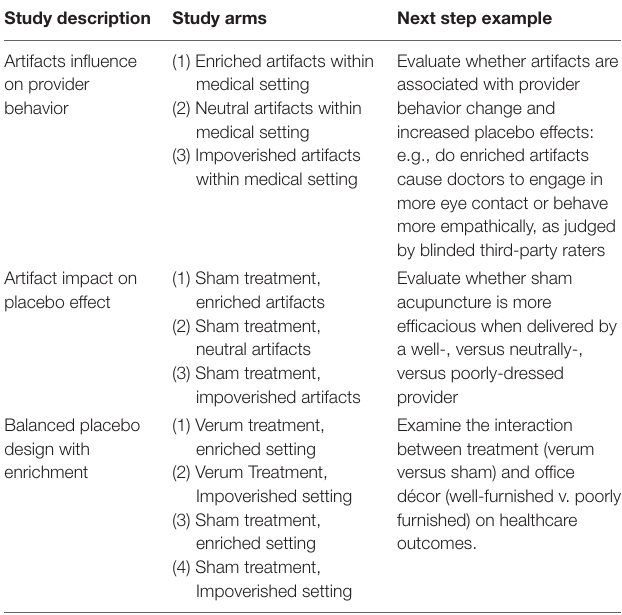
TABLE 1 | Artifacts and placebo effects: Future research